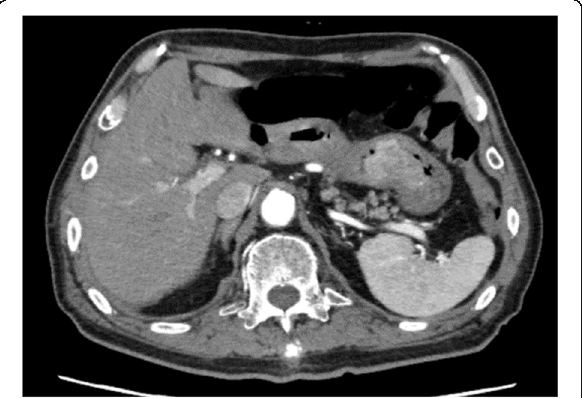
Fig. 2 Abdominal computed tomography. Enhanced gastric tumor incarcerated to the